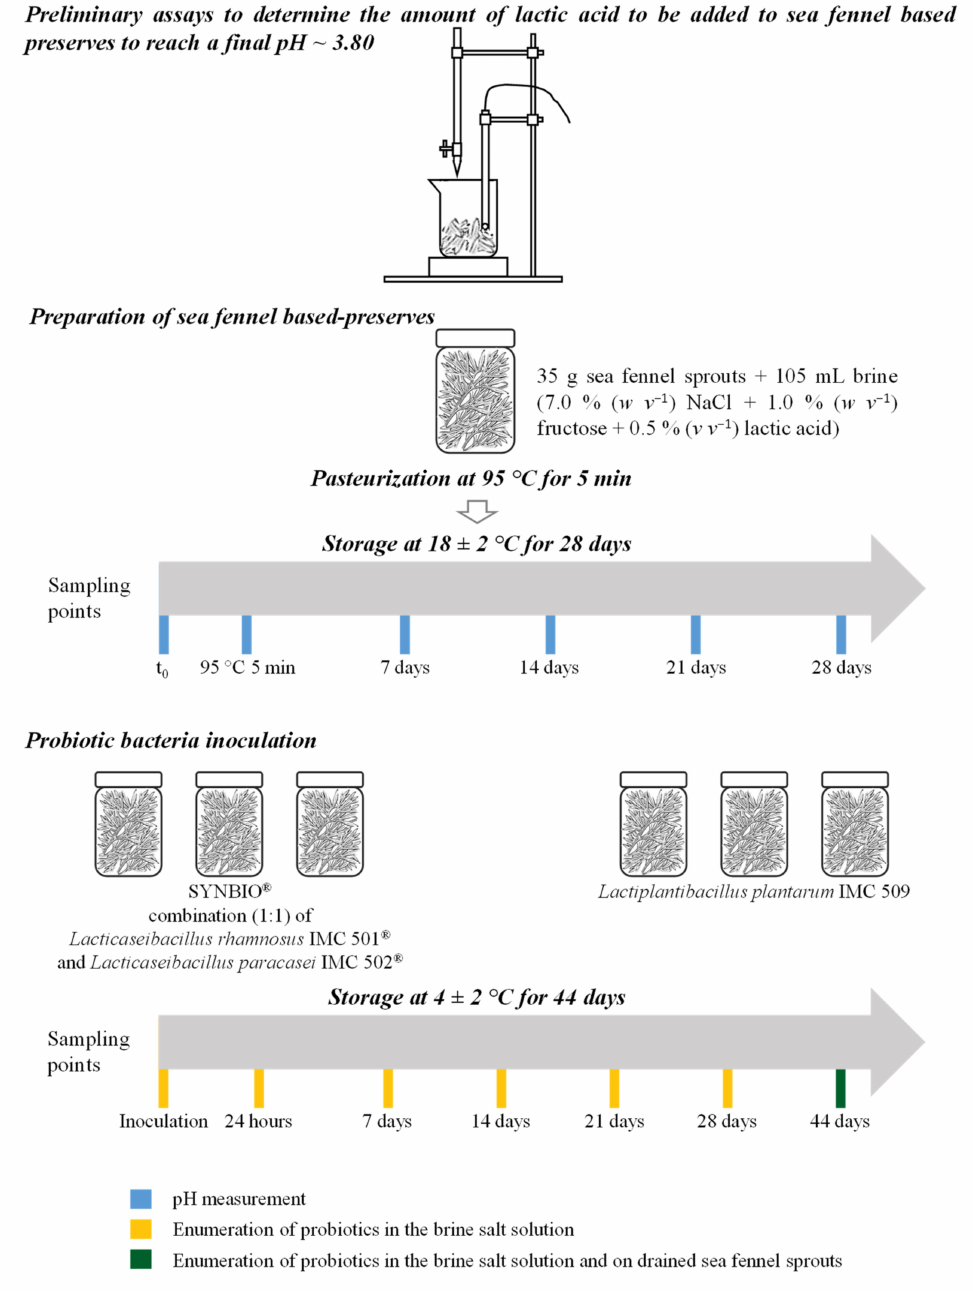
Figure 2. Experimental design of the